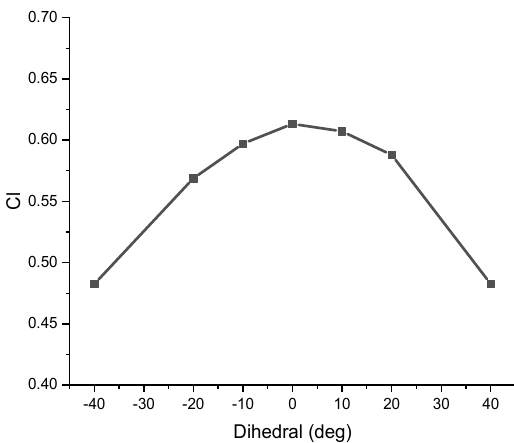
Figure 12. Average lift of cases with different dihedral.